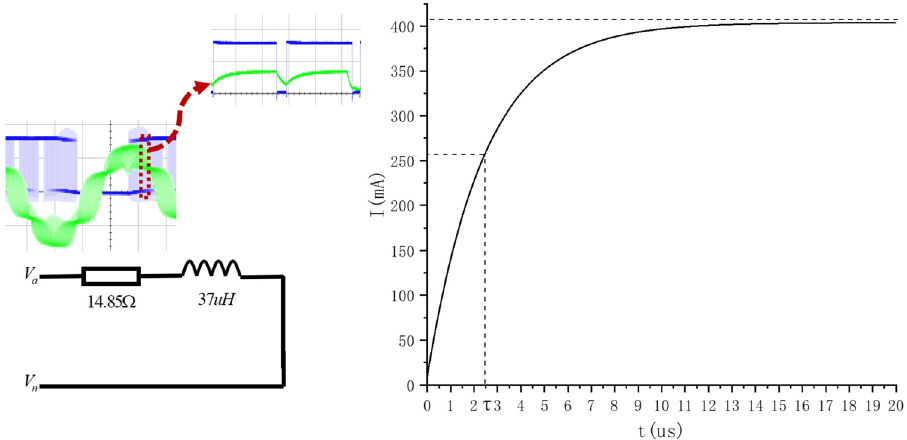
Figure 16. Single phase equivalent circuit of motor.